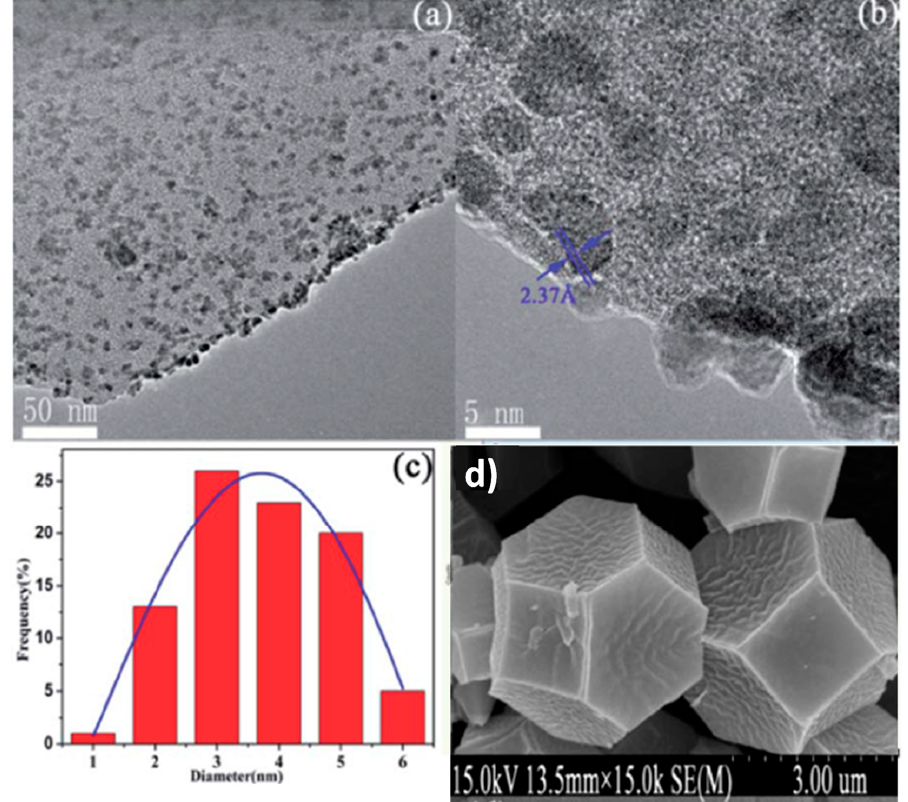
Figure 3. TEM images ( a , b ) and Pd NPs size distribution ( c ) for Pd(0.5wt%)/DUT-67. ( d ) SEM image of DUT-67. Reproduced with permission from [53].